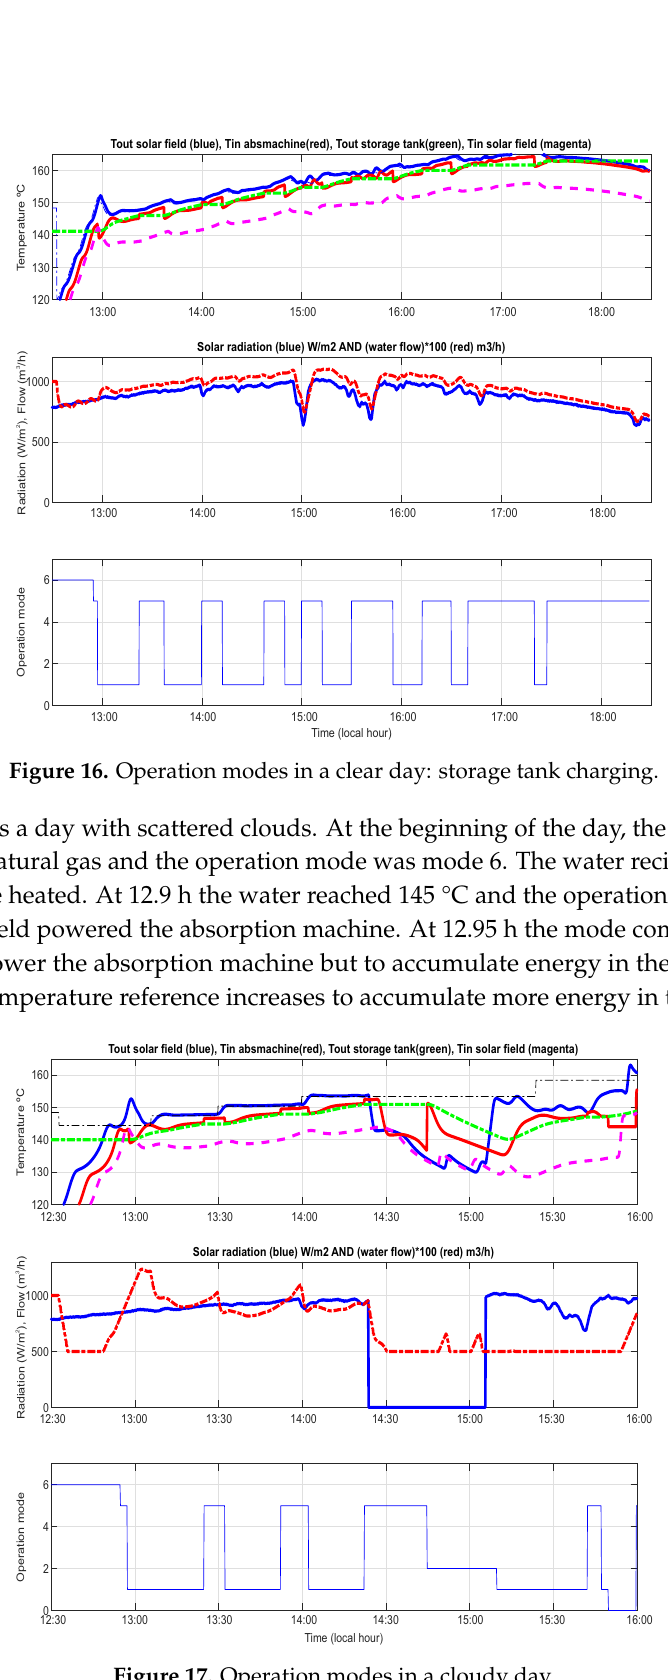
Figure 17. Operation modes in a cloudy